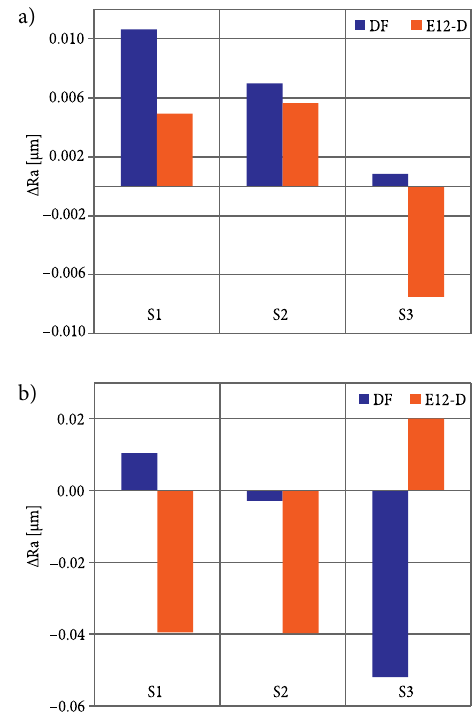
Fig. 3. High pressure pump fuel delivery versus common rail fuel pressure